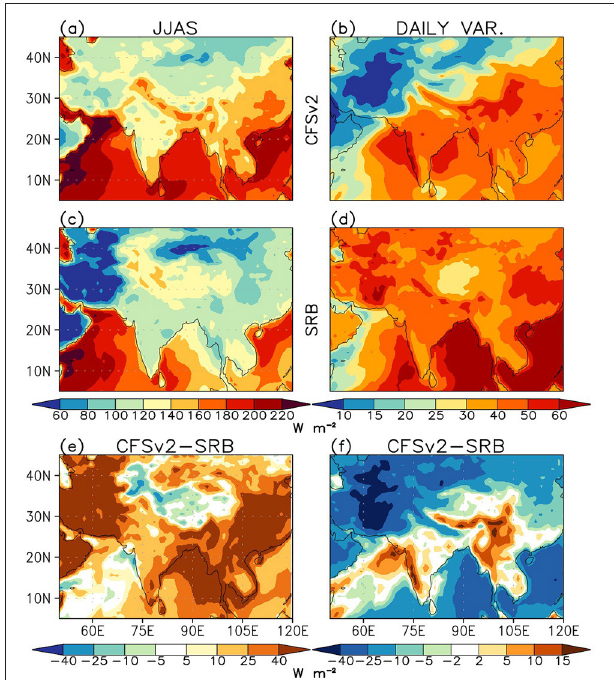
FIGURE 6 | Mean (1982–2009) seasonal (JJAS) surface NRAD based on (a) ensemble mean JUNIC hindcasts and (b) observations from the SRB project. (c,d) Show the same except for the daily variability in NRAD in JJAS. Differences in the (e) seasonal mean and (f) daily variability of NRAD between the JUNIC hindcasts and SRB are shown in the bottom row. Units are in Wm − 2